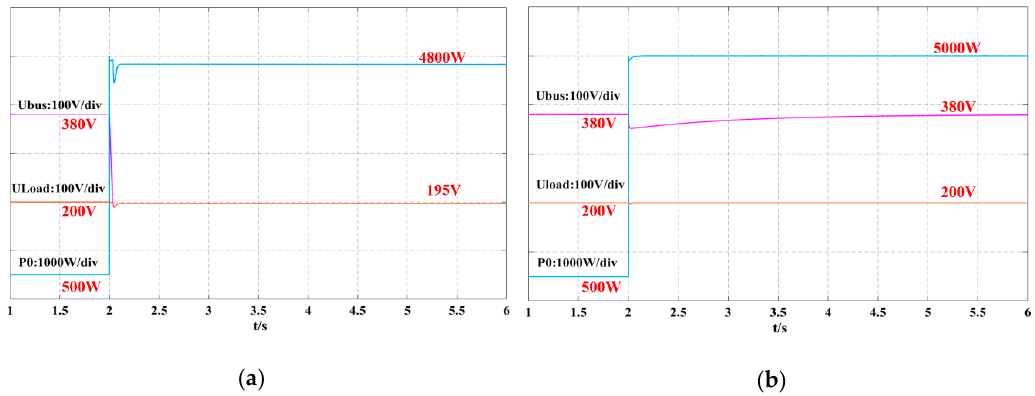
Figure 8. Simulation results of the power of constant power load (CPL) stepping from 500 W to 5000 W: ( a ) The #1 simulation results of DC bus voltage, load voltage and the power of CPL; ( b ) The #2 simulation results of DC bus voltage, load voltage and the power of CPL.